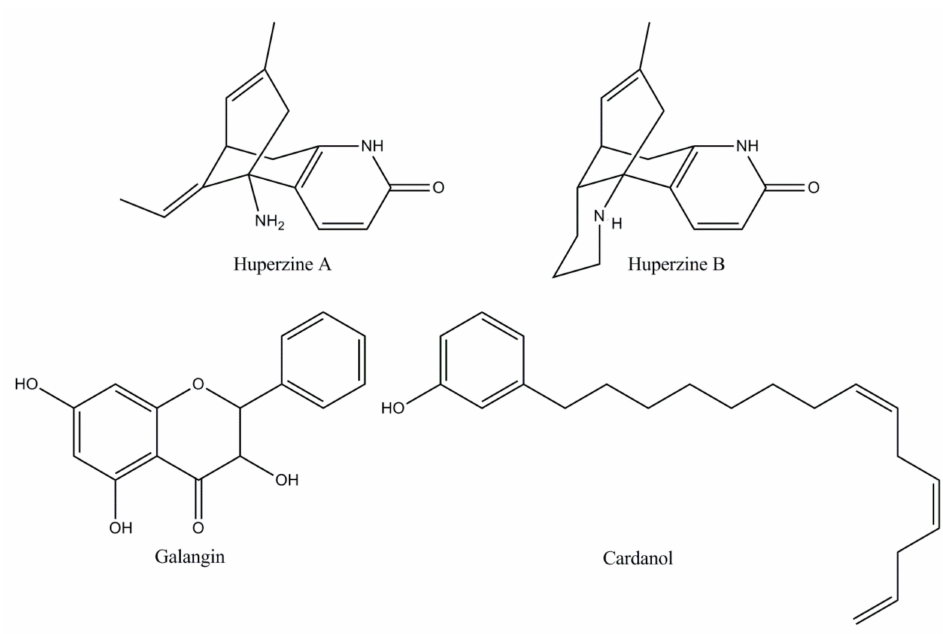
Figure 5. The molecular structures of naturally derived ChEIs: Huperzine A and B, Galangin, and